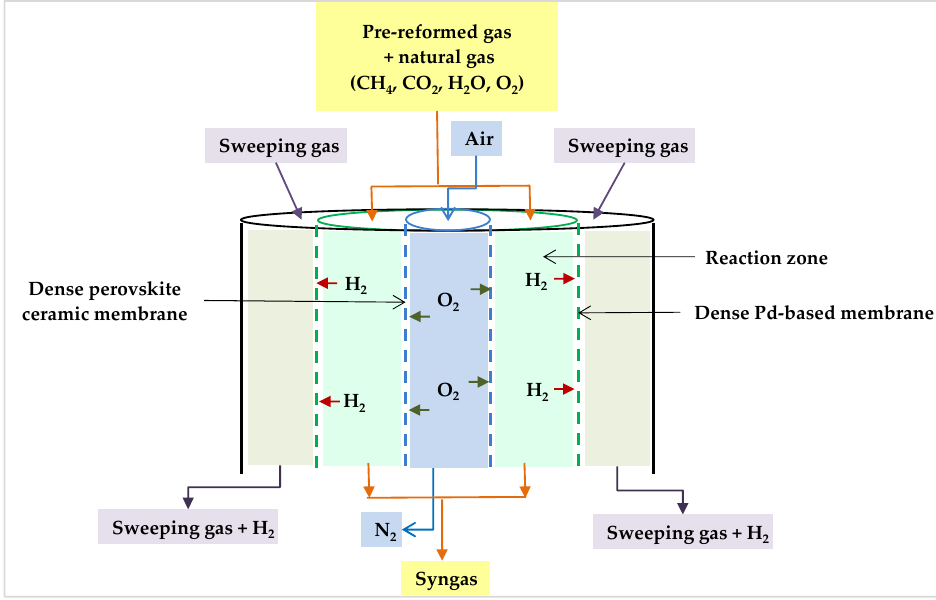
Figure 17. Proposed permeable membrane reactor [87].